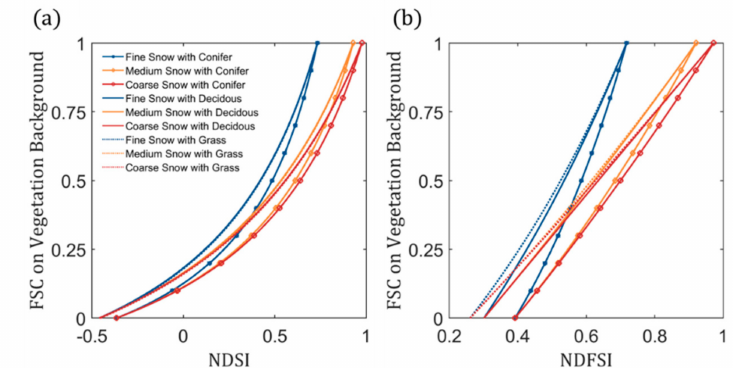
Figure 5. Fractional snow cover versus normalized di ff erence snow index (NDSI) ( a ) and normalized di ff erence forest–snow index (NDFSI) ( b ) on vegetation